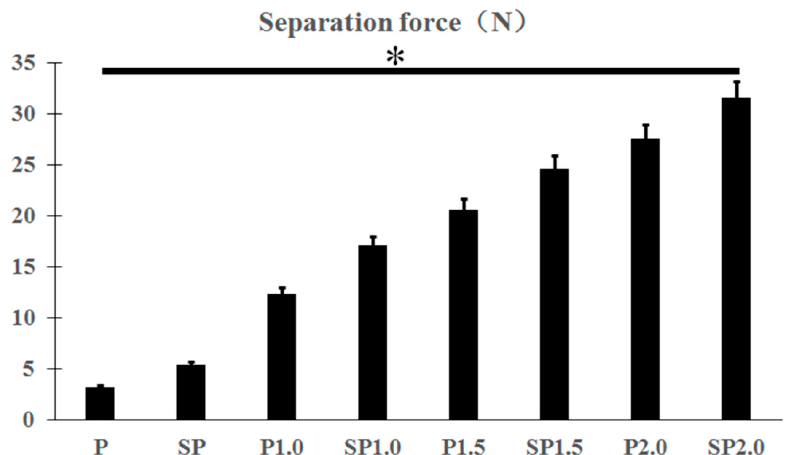
Figure 7. Separation force of different peek specimens with soft tissue. * p < 0.05.